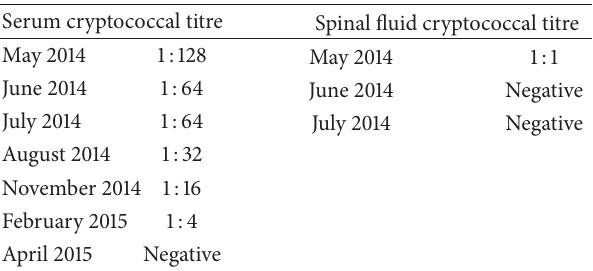
Table 1: Patient cryptococcal titre trend during follow-up